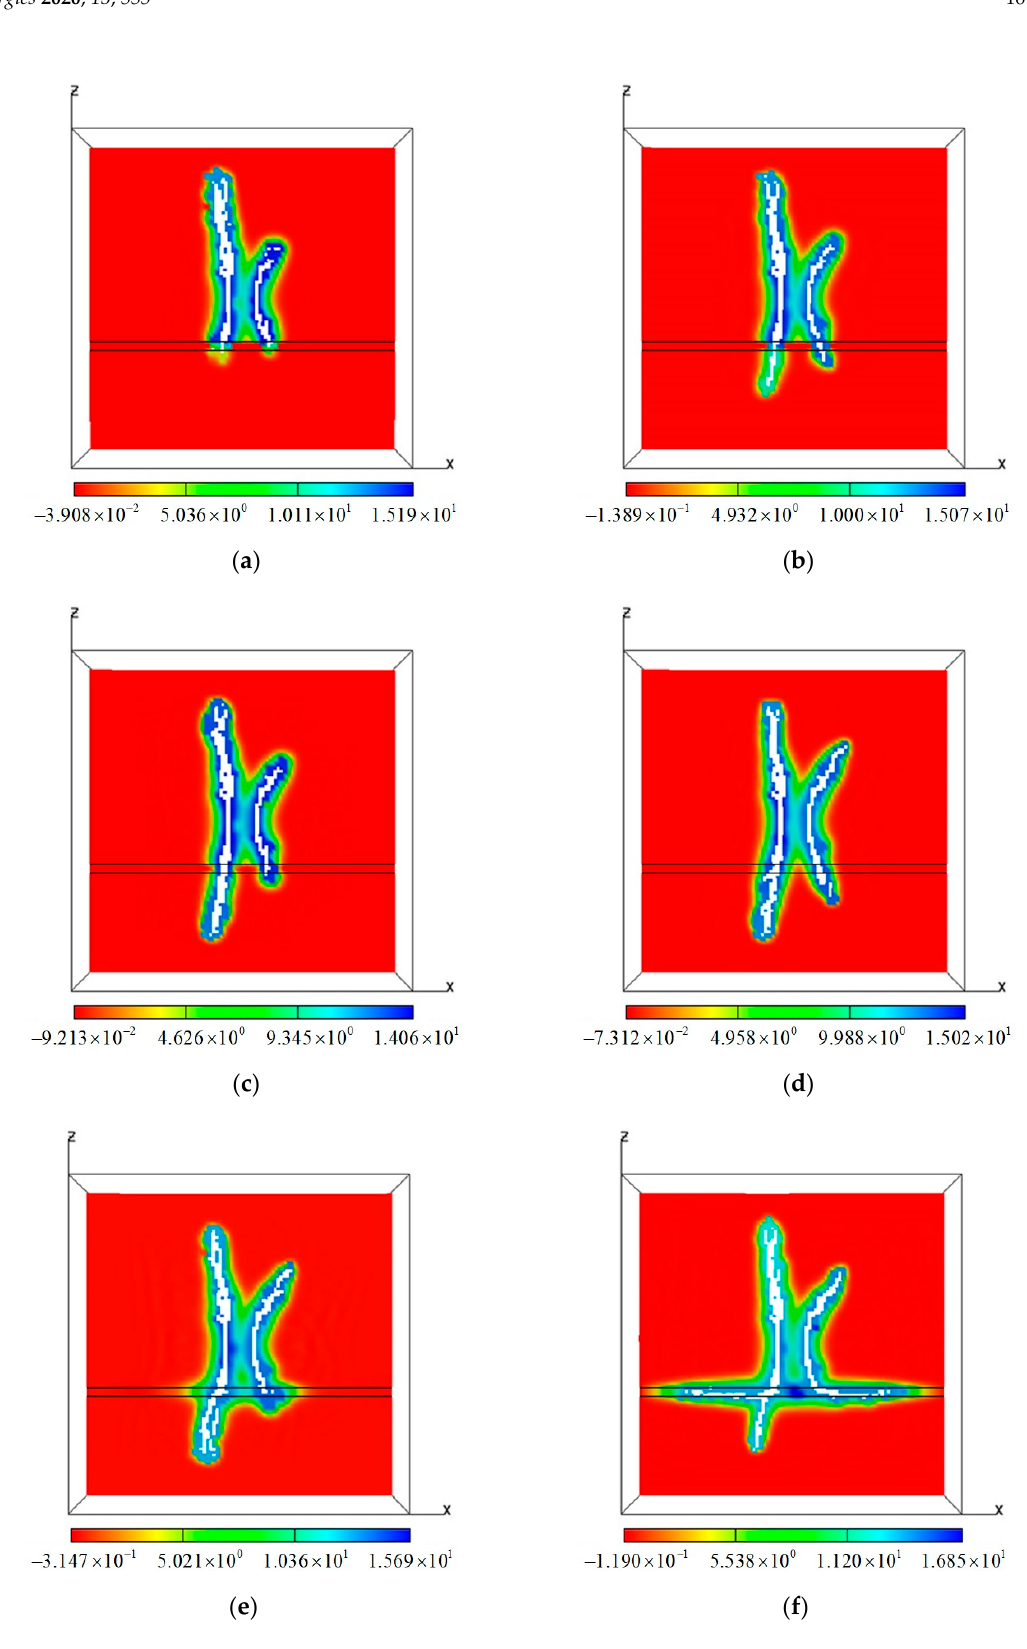
Figure 12. The seepage fields (MPa) of models with different interlayer permeability at t = 2000 s: ( a ) Multi-k1, k 1 / k 0 = 10 − 3 ; ( b ) Multi-k2, k 2 / k 0 = 10 − 2 ; ( c ) Multi-k3, k 3 / k 0 = 10 − 1 ; ( d ) Multi-00, k 0 / k 0 = 10 0 ; ( e ) Multi-k4, k 4 / k 0 = 10 1 ; ( f ) Multi-k5, k 5 / k 0 = 10 2 .